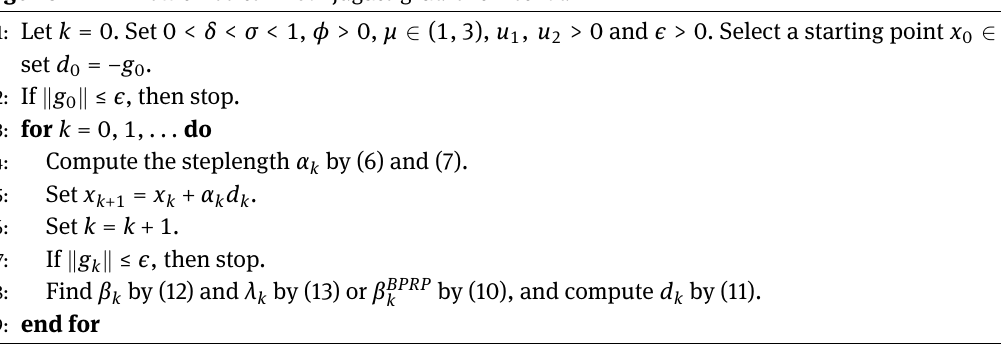
Algorithm 1 A new three-term conjugate gradient